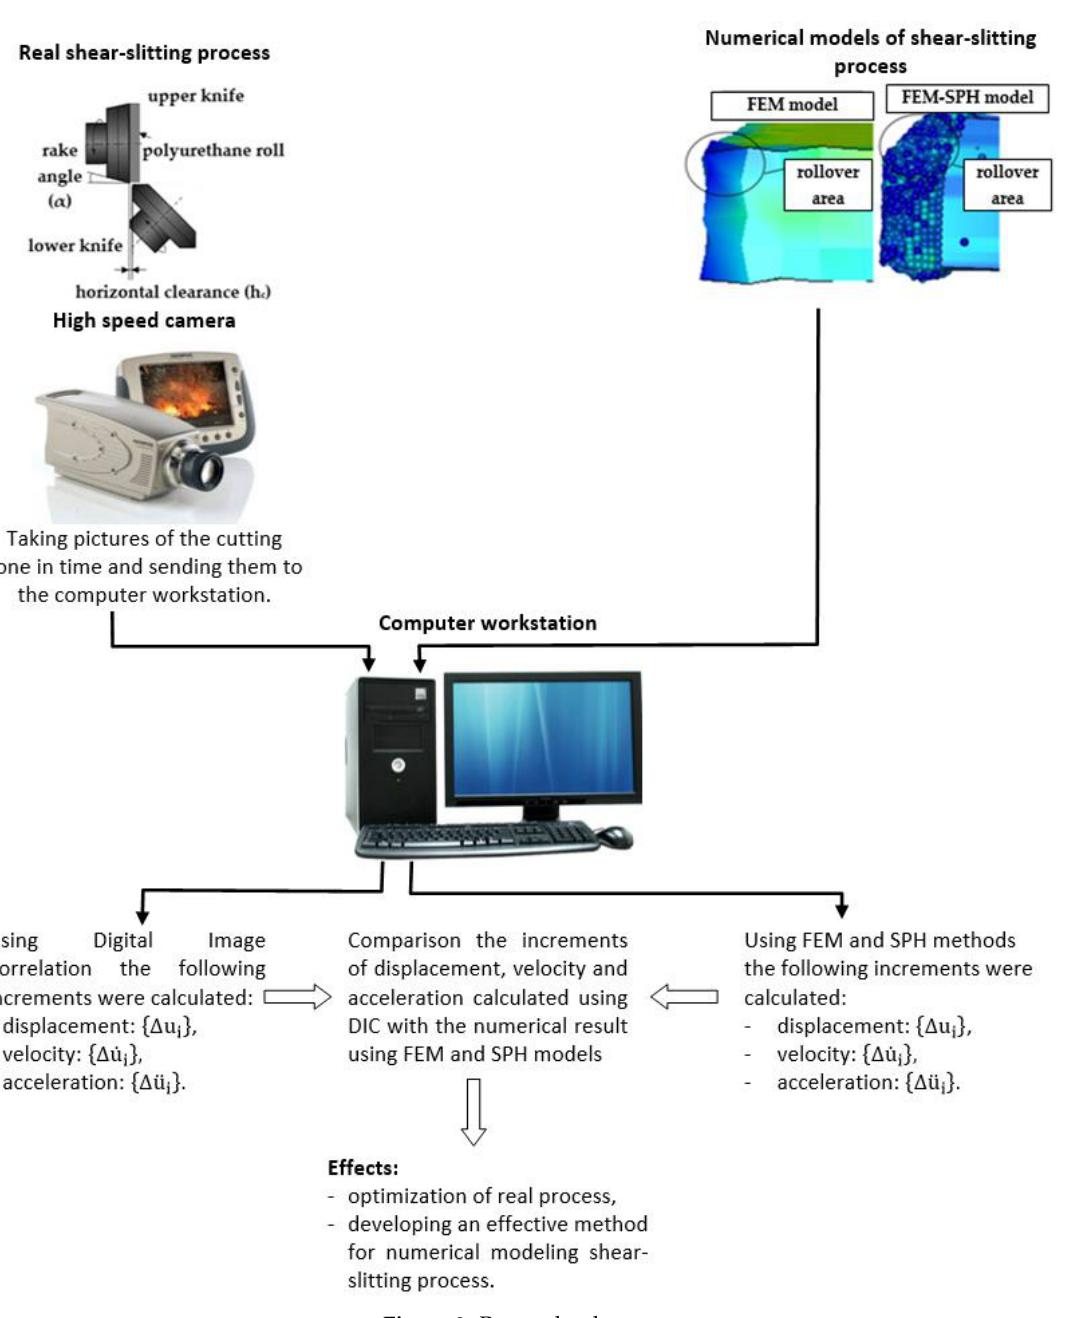
Figure 2. Research Figure 2. Research scheme. Table 3. Shear-slitting parameters.